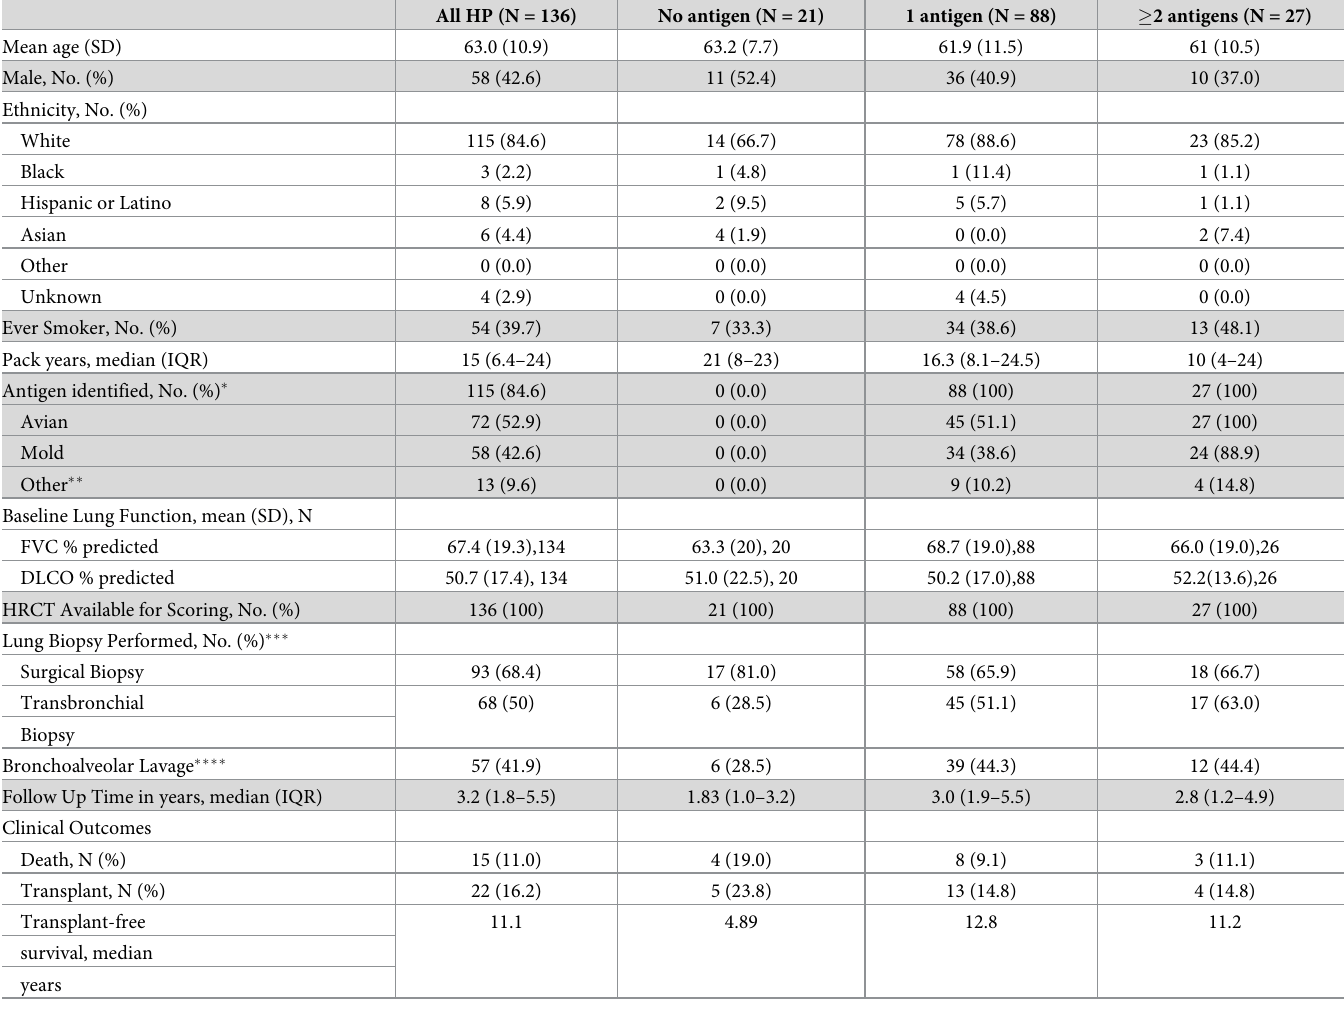
Table 1. Demographic characteristics of retrospective cohort.